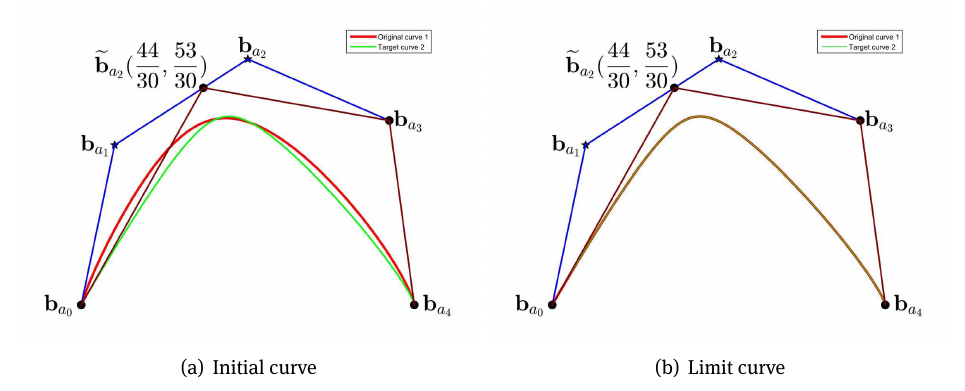
Figure 8: Limits of the quadratic GT-Bézier curve of single